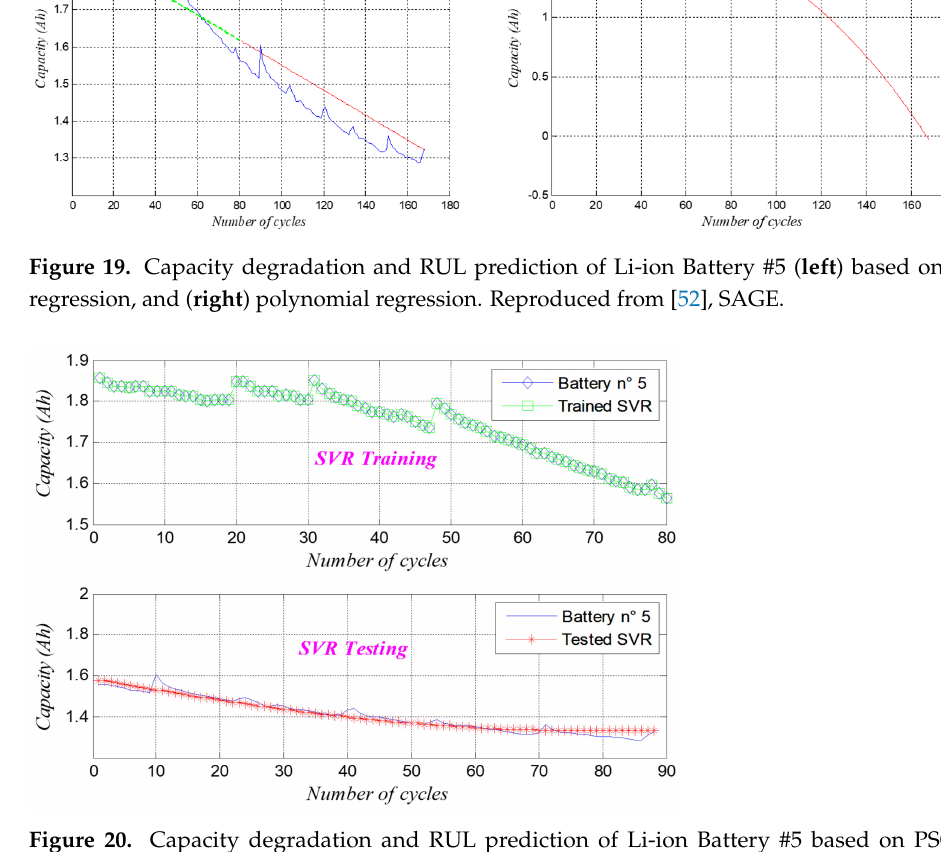
Figure 20. Capacity degradation and RUL prediction of Li-ion Battery #5 based on PSO-SVR ([C, ε , γ ] = [0.3, 2.0359, 19.8 × 10 − 6 ]). Reproduced from [12],